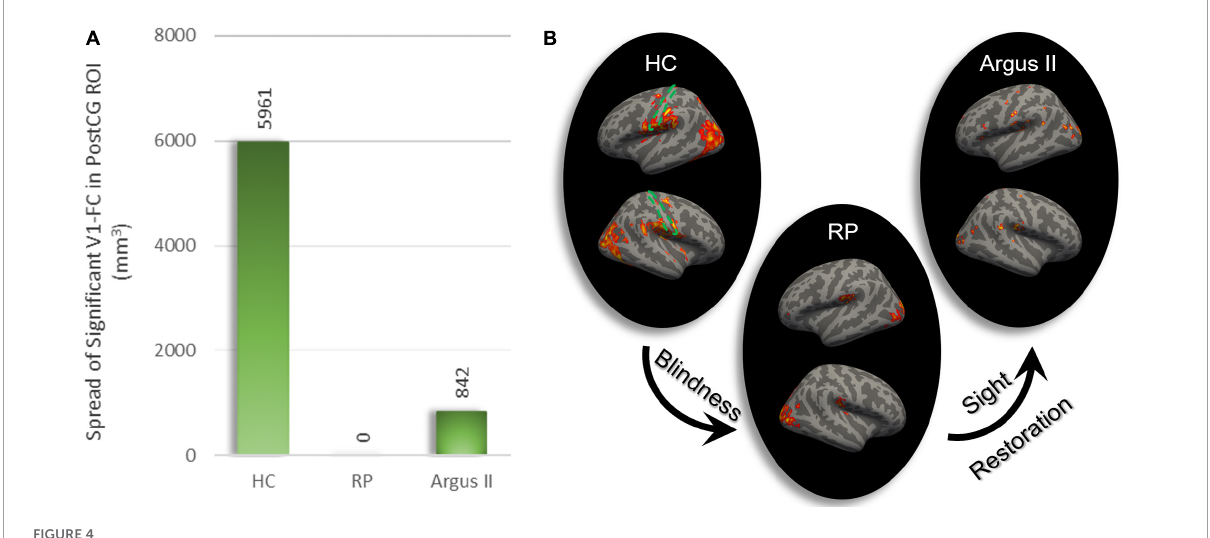
FIGURE4 The extent of rsFC to V1. The volumetric extent in PostCG shows significant rsFC to V1 as the seed was calculated in mm 3 (A) . This spread of connectivity drastically reduced after blindness and partially increased following sight restoration in Argus II. Areas in the whole brain with significant rsFC to V1 for each of the three study groups are shown on the right (B) . The dotted green area represents PostCG/primary somatosensory cortex